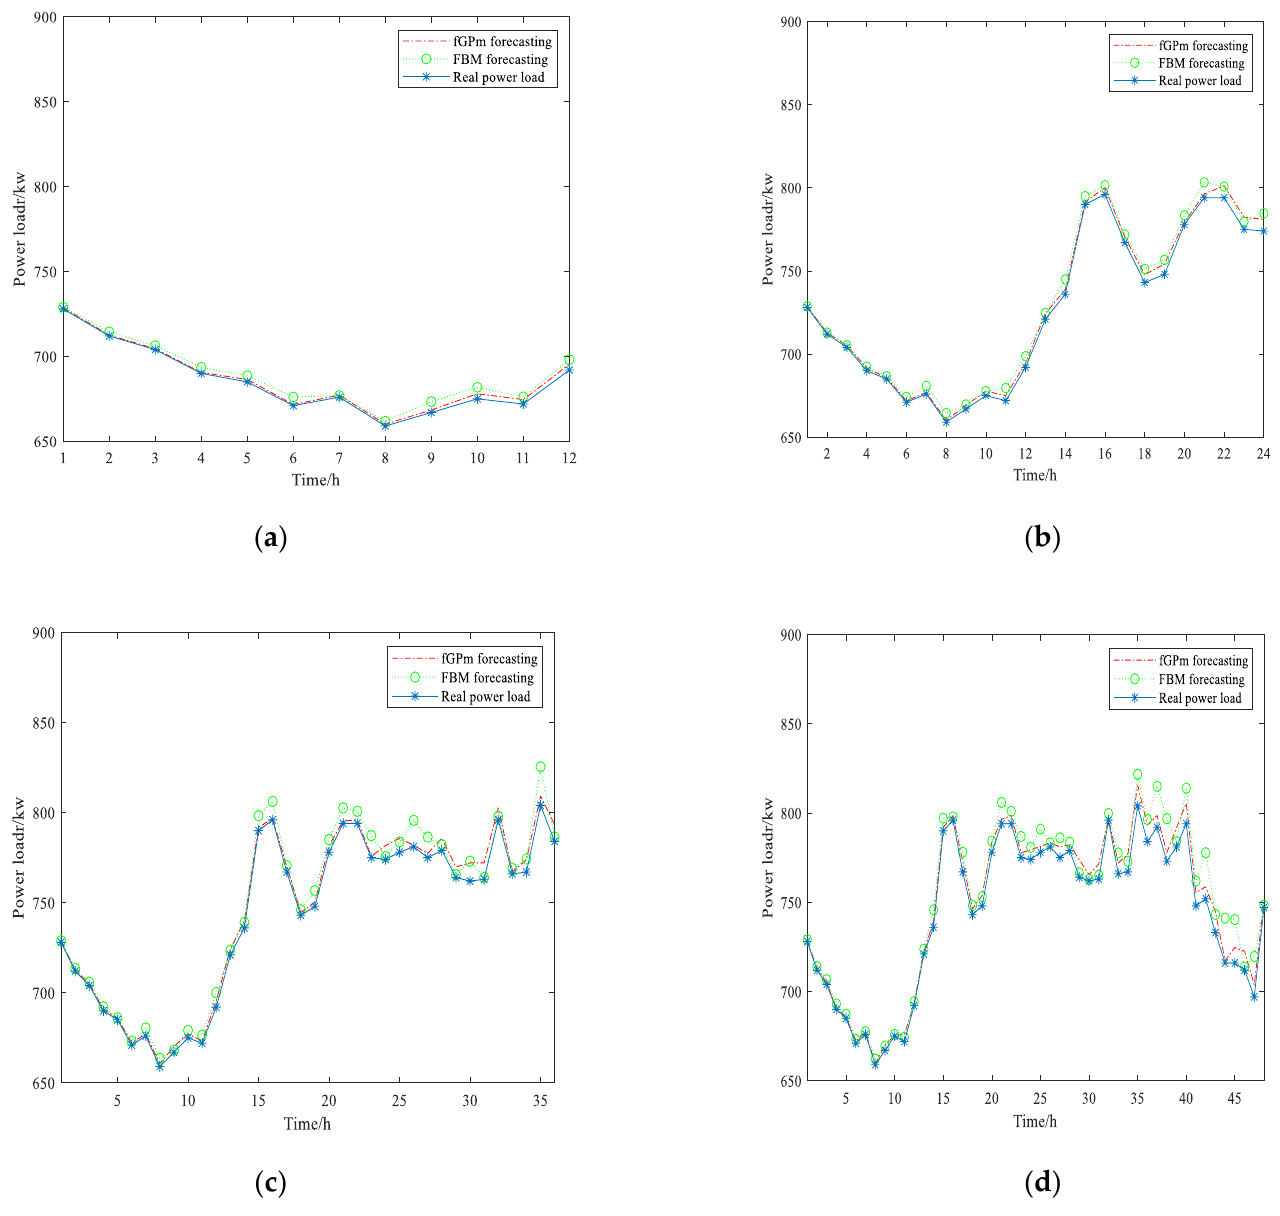
Figure 15. Comparison of two forecasting models in weekend. ( a ) 6 h ( b ) 12 h ( c ) 18 h ( d ) 24 h. Table 4. The weekend forecasting relative error (%) of power loads on adjacent